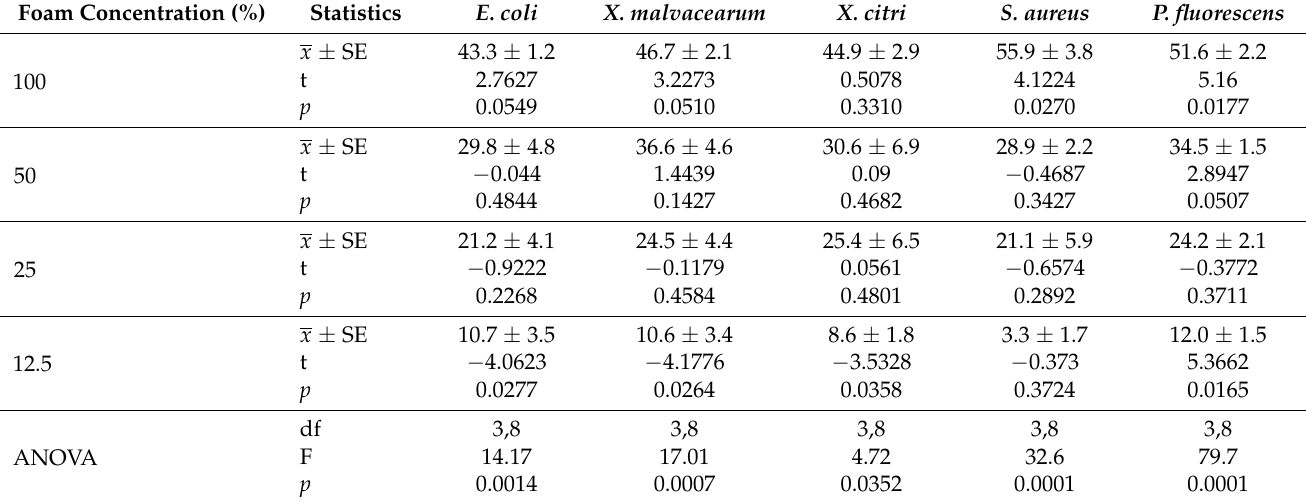
Table 9. Impact of P. costalis foam concentrations (100, 50, 25 and 12.5%) on the growth of chosen pathogenic microbes. Foam Concentration